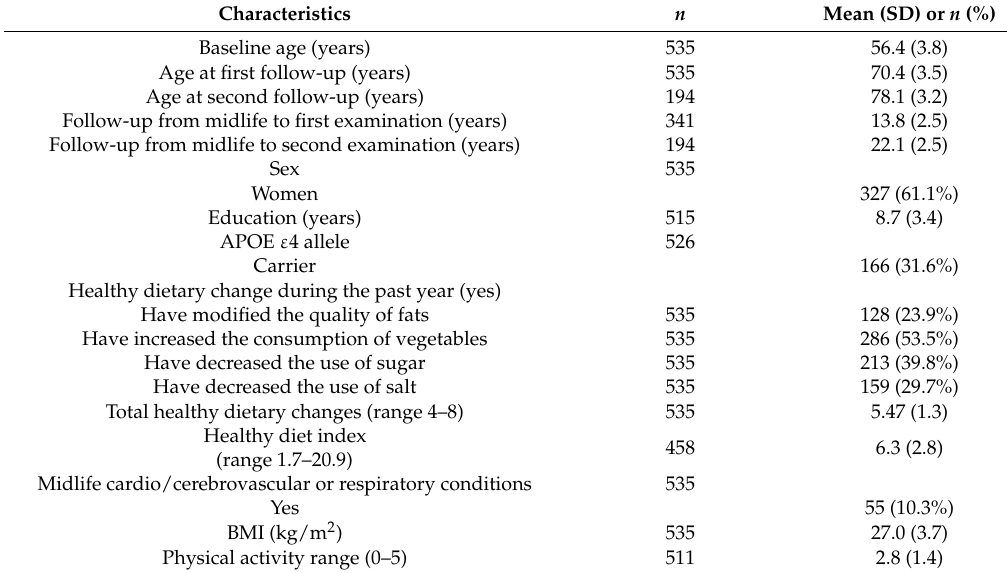
Table 2. Sociodemographic and clinical characteristics of participants included in the analyses.